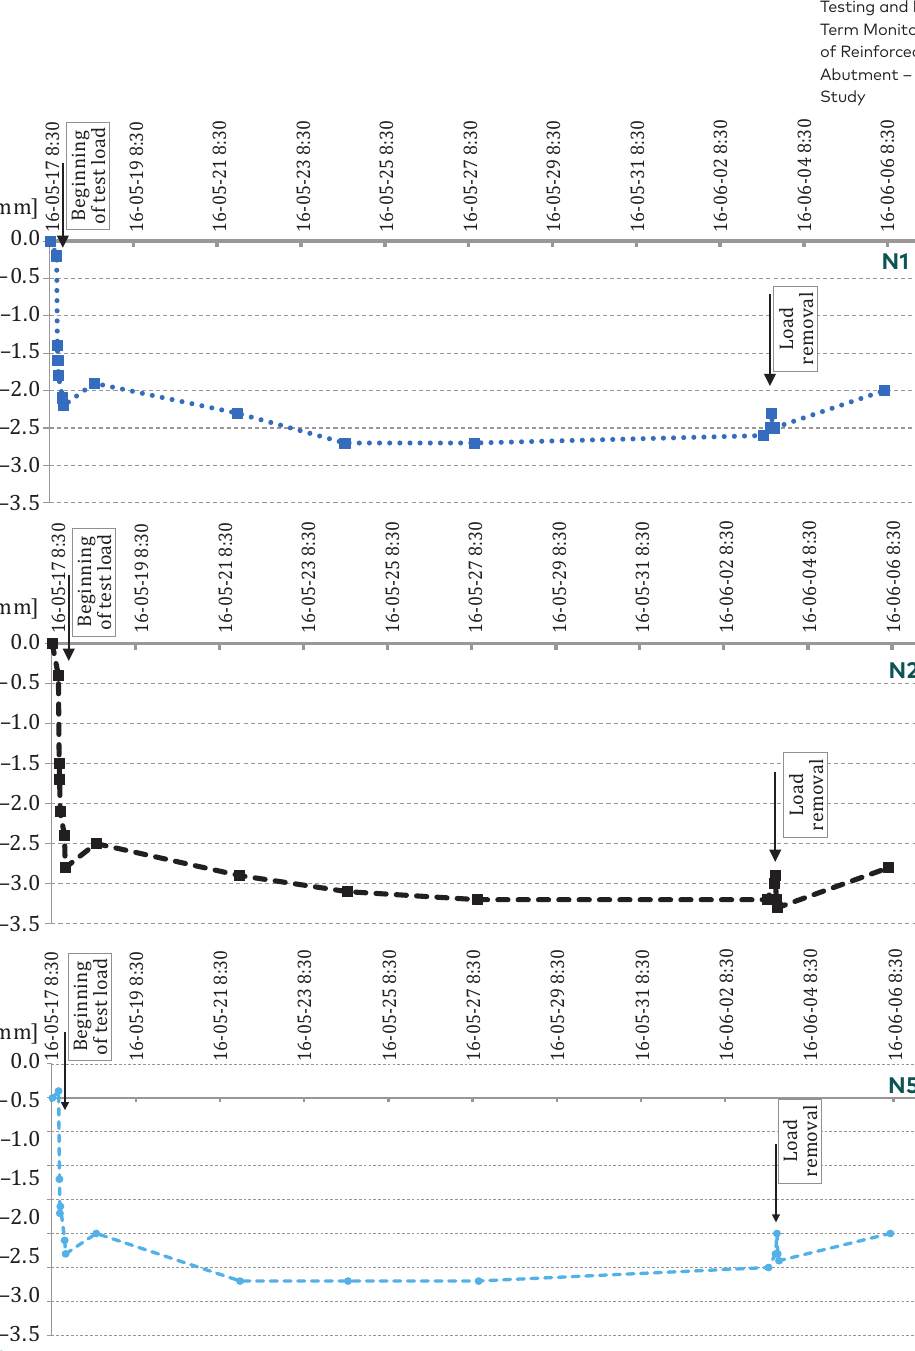
Figure 8. Vertical displacements (in mm) of control benchmarks N1, N2, N5 within 20 days from starting test load